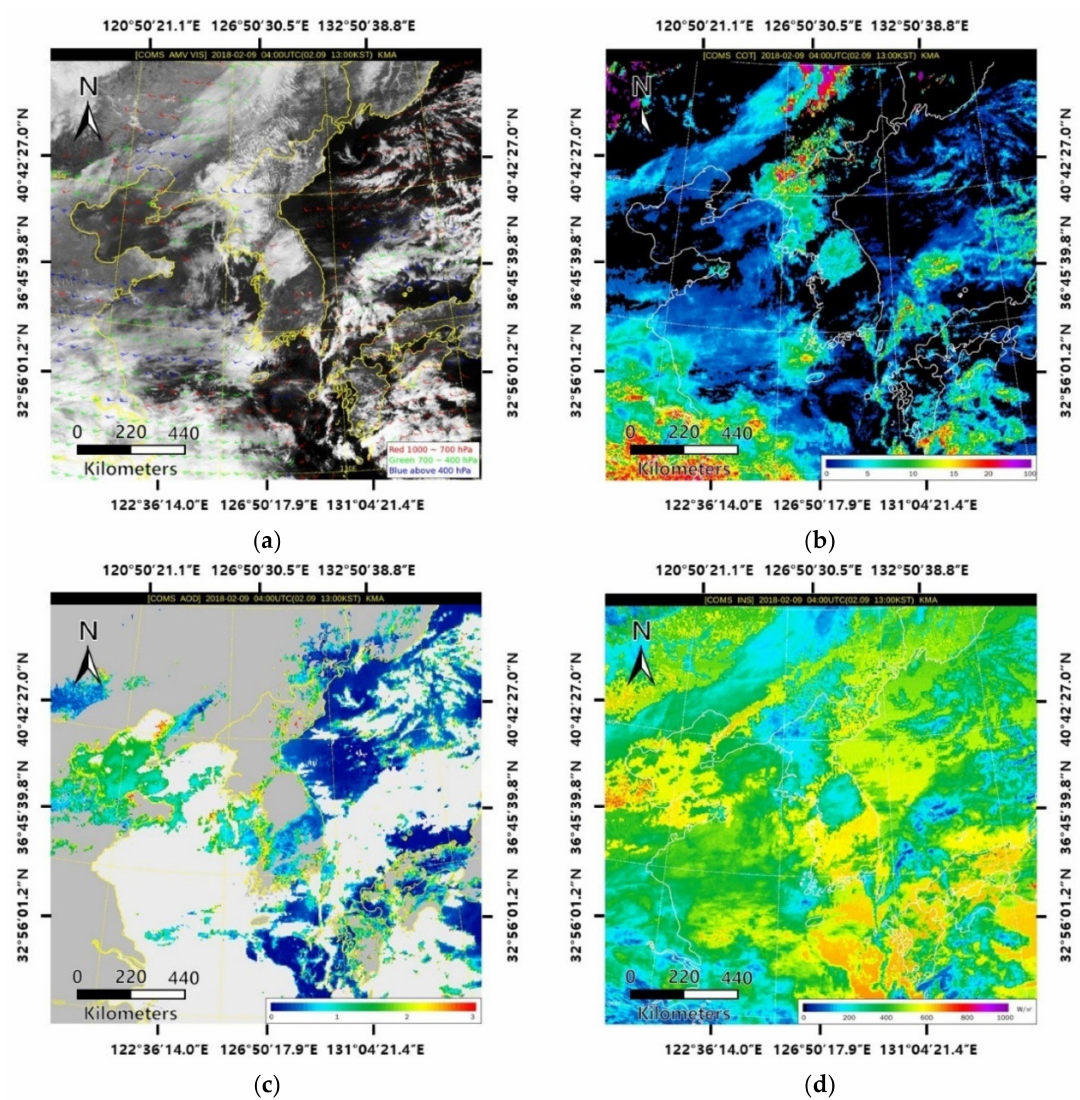
Figure 2. Four satellite images at 13:00 on 28 February 2016: ( a ) atmospheric motion vector image; ( b ) cloud optical thickness image; ( c ) aerosol optical depth image; ( d ) insolation image.